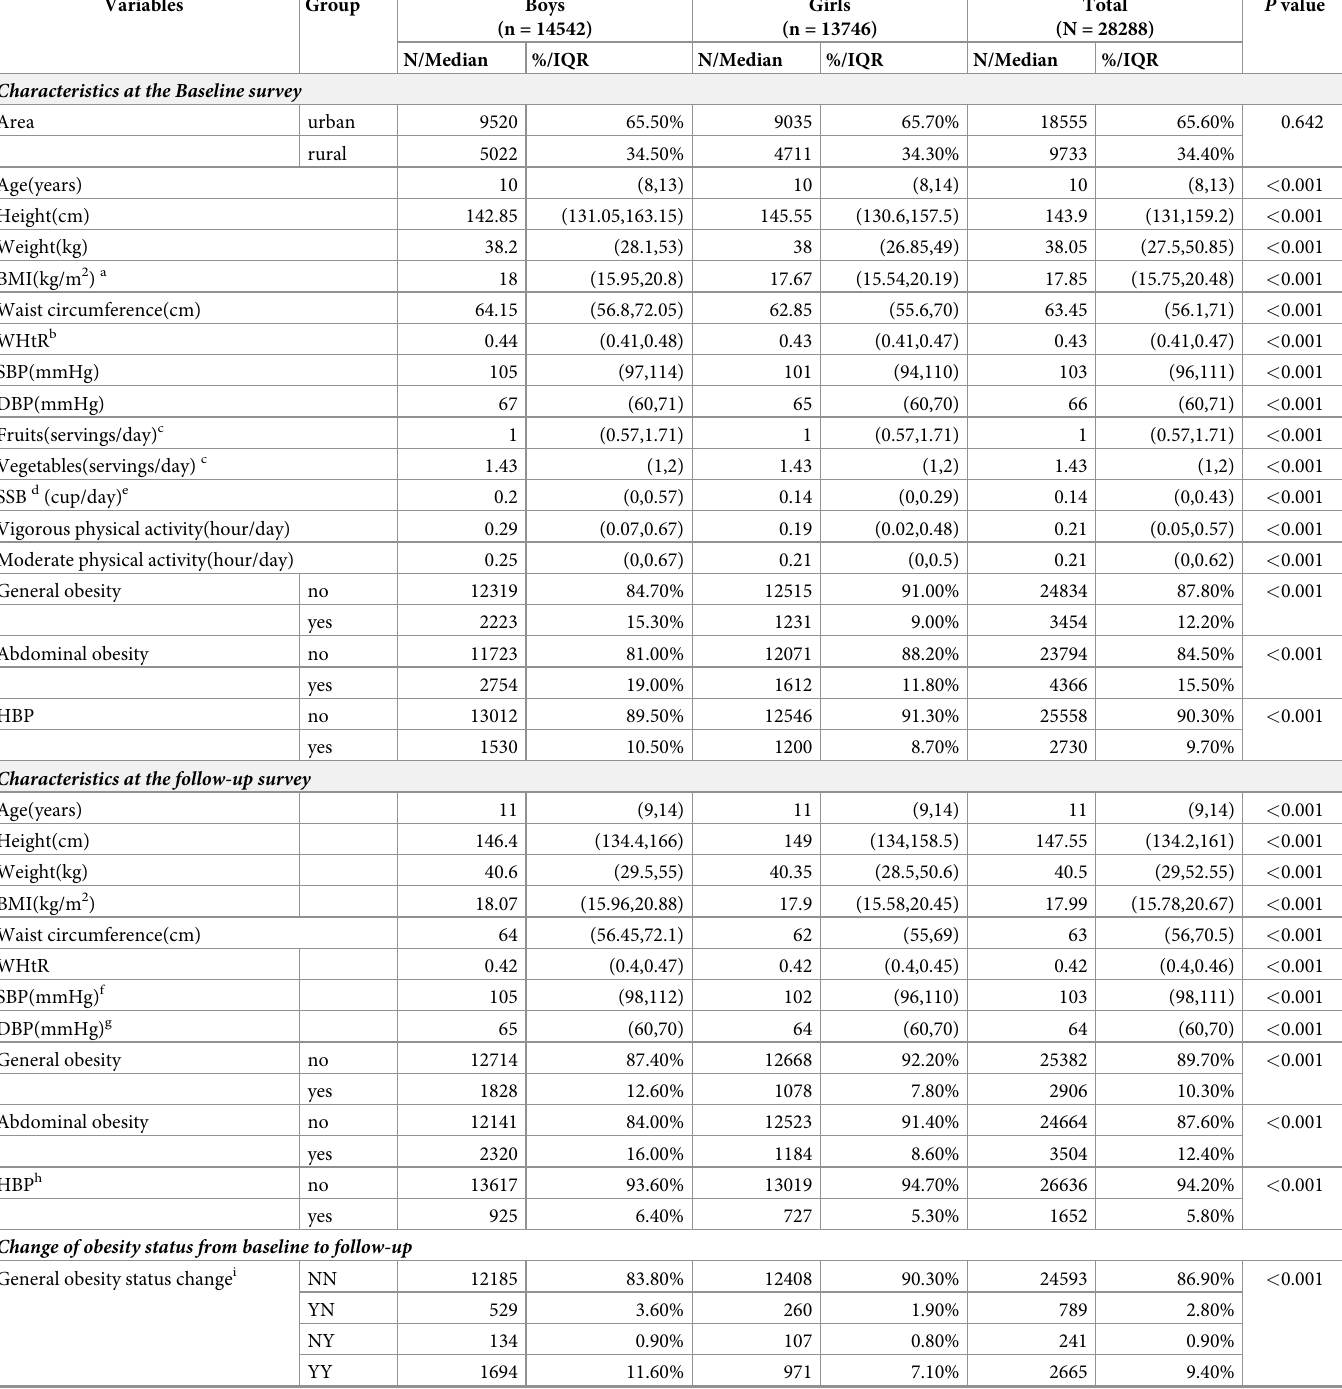
Table 1. General characteristics of the study